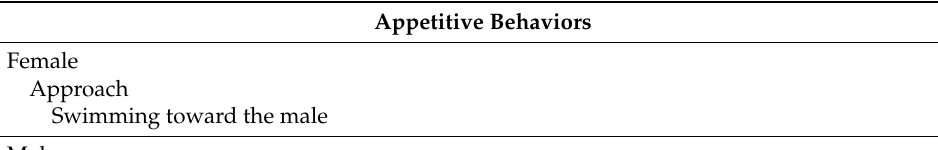
Figure 2. Zebrafish sexual behavior. Time course (left to right) of appetitive, preconsummatory, and consummatory behaviors. See Table 1 for behavioral descriptions. Table 1. Definition of parameters for the zebrafish sexual behavior.